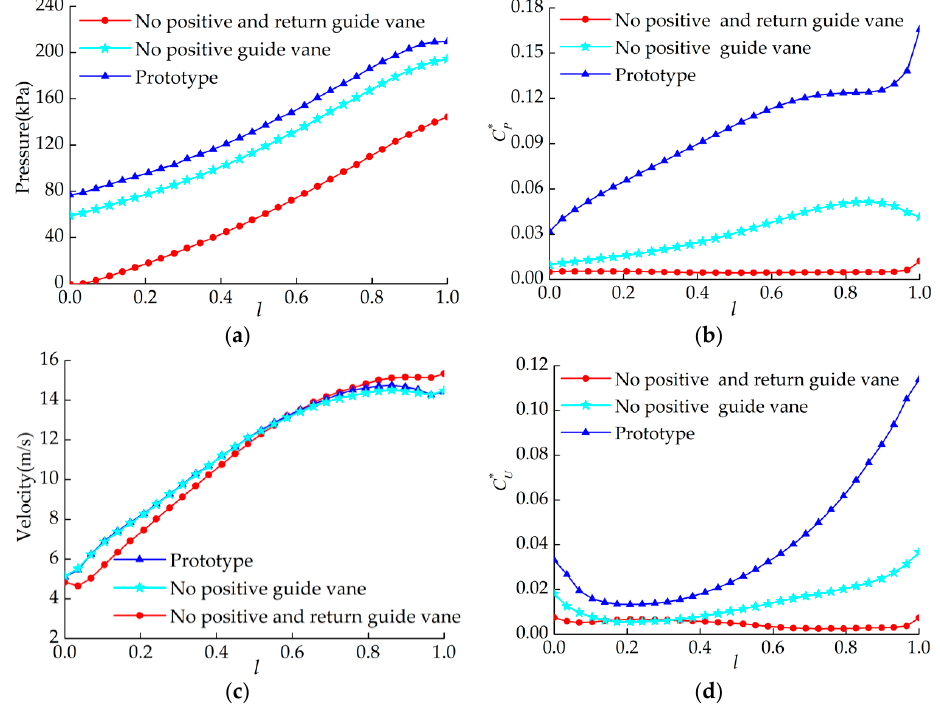
Figure 6. The time-average and fluctuation intensity curves of pressure and velocity on the blade surface of the impeller with different blade numbers of the guide vane. ( a ) The curves of the pressure time-average; ( b ) the curves of pressure fluctuation intensity; ( c ) the curves of the velocity time-average; ( d ) the curves of velocity fluctuation